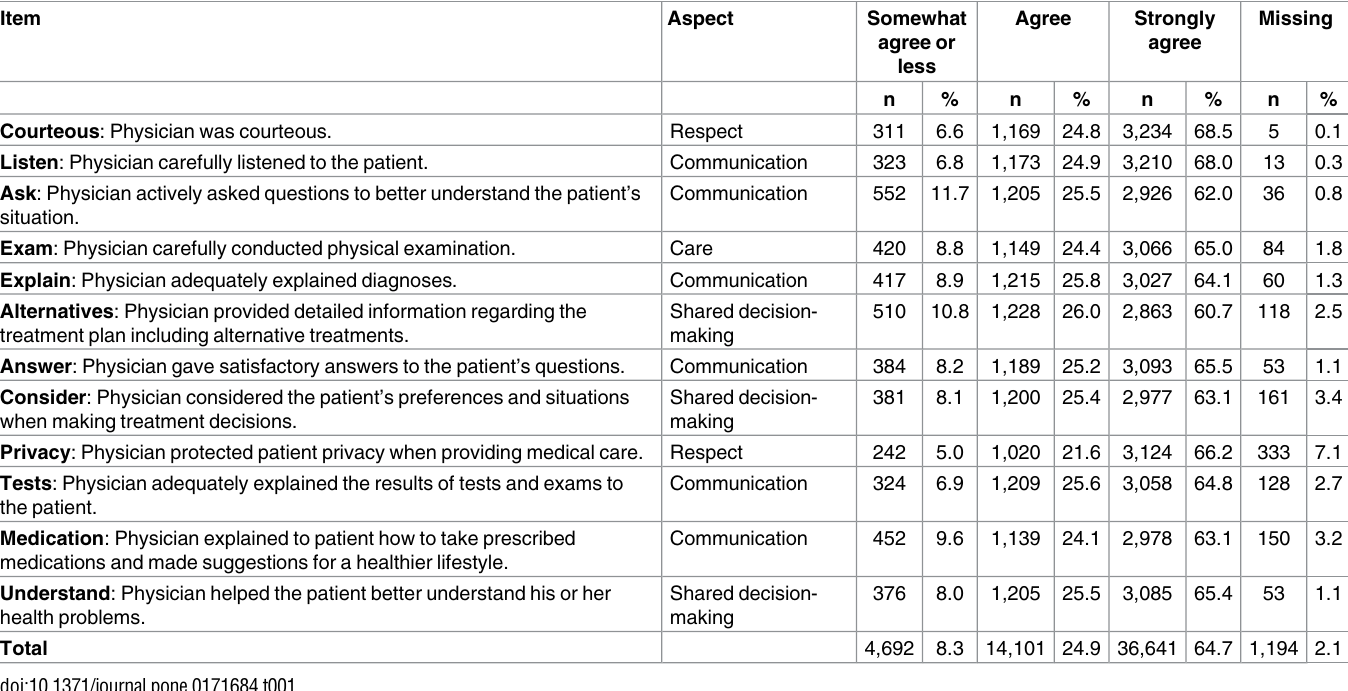
Table 1. Patient experiencewith outpatient encounters at public hospitals in Shanghai: General